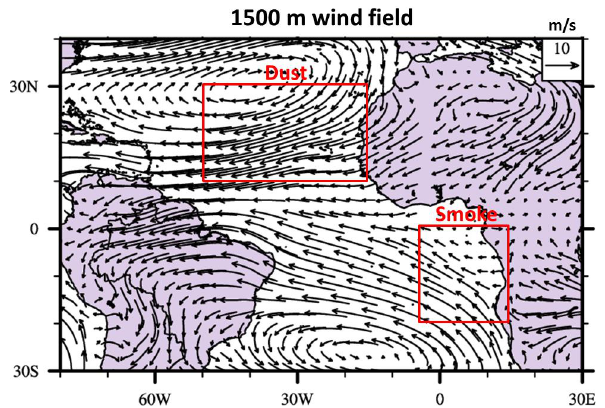
Figure 1. Spatial domains analyzed (red boxes) and wind fields (ar- rows) from ECMWF data for July and August from 2007 to 2012. The northern region (10–30 ◦ N, 50–15 ◦ W) is along the Saharan dust transport pathway over the tropical North Atlantic, while the southern region (20–0 ◦ S, 5 ◦ W–15 ◦ E) is along the smoke transport pathway over the tropical South